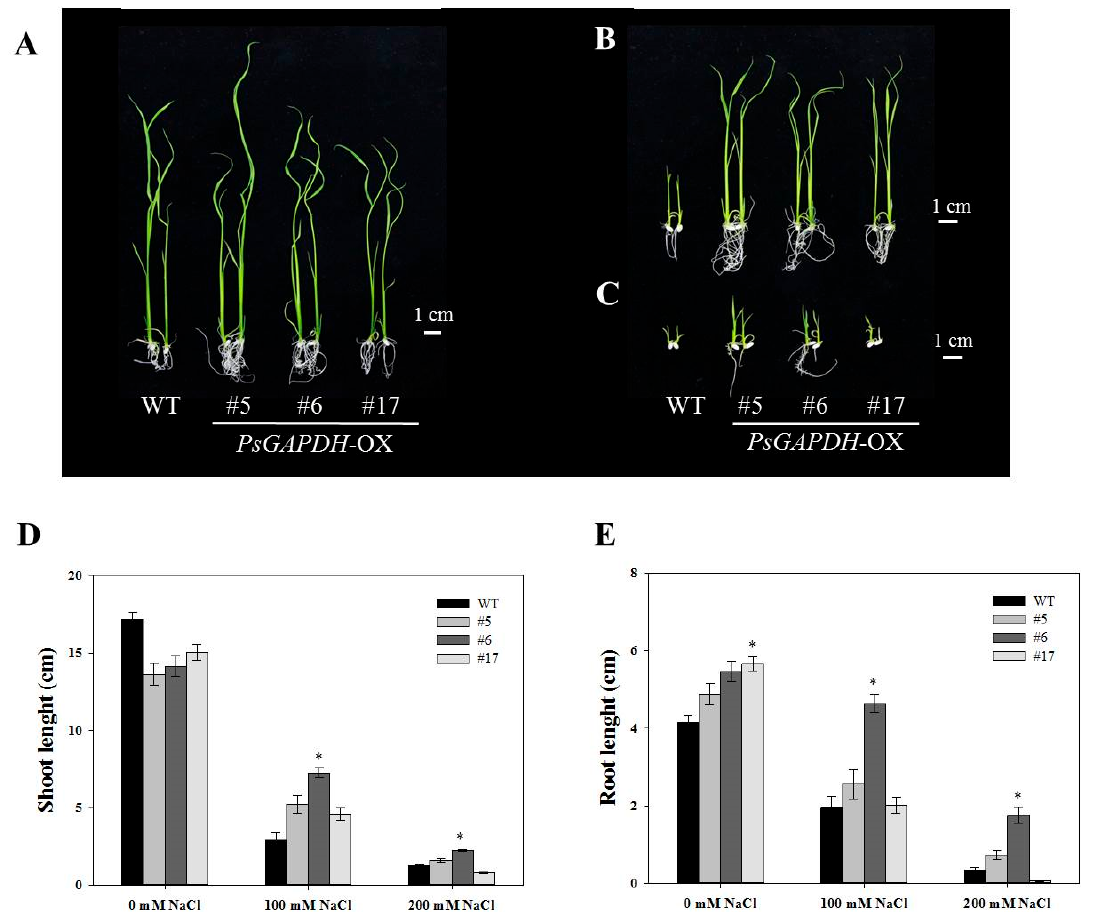
Figure 3. Phenotypic comparison of PsGAPDH -OX transgenic plants under salt stress. Phenotypes of wild-type and PsGAPDH -OX rice plants grown on MS medium containing 0 mM ( A ), 100 mM ( B ), and 200 mM ( C ) NaCl for 2 weeks. Effect of 2 weeks of salt stress on shoot ( D ) and root ( E ) lengths of PsGAPDH -OX plants. For each treatment, 15 seedlings were measured. Error bar represents the SE of three replicates. Significant differences depending on t -tests are indicated by asterisks (*, p < 0.05).